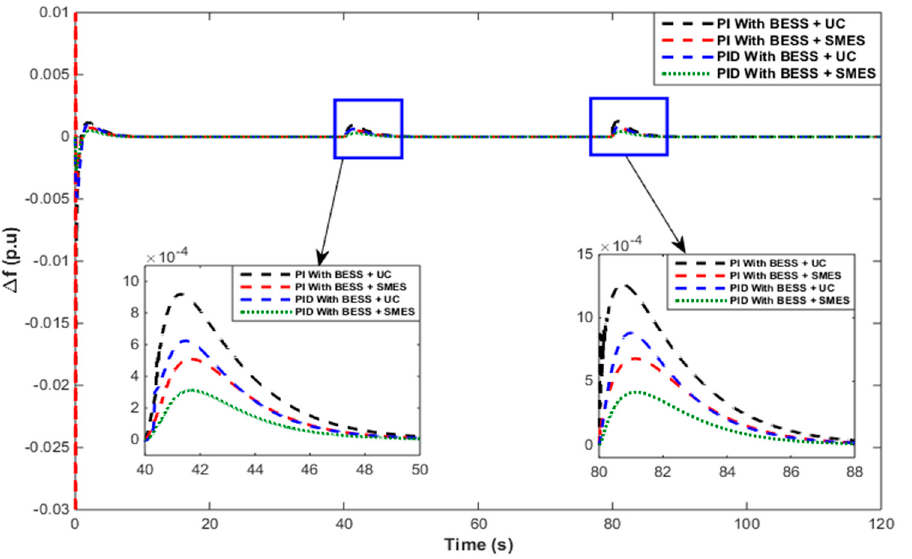
Figure 18. Comparative performances of the frequency responses of BESS + UC (case 2) and BESS + SMES (case 3) with the FPA-optimized PI and PID controllers employed in a hybrid response model.